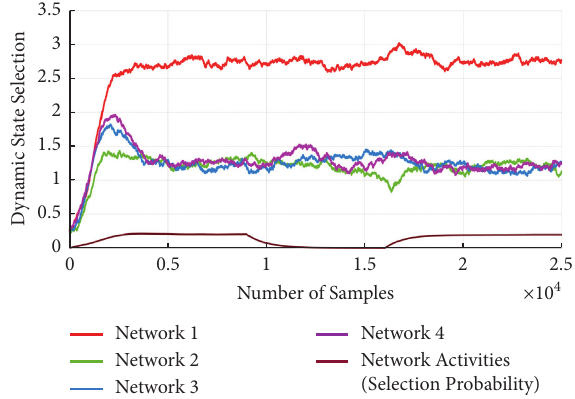
Figure 11: Effect of threshold on network connectivity for � 10 ) . sensitivity � 5 ( V thrl Table 2: Effect of threshold on network